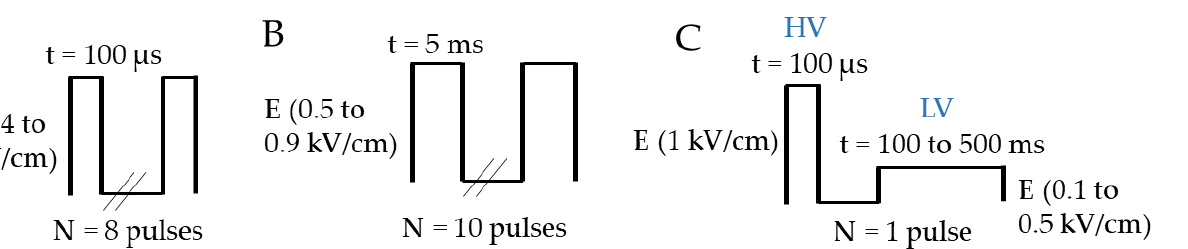
Figure 1. Schematic representation of electrical parameters used. ( A ) ECT pulse protocol (8 pulses of 100 µs at 1.4 to 2 kV/cm, 1 Hz), ( B ) GET pulse protocol (10 pulses of 5 ms at 0.5 to 0.6 kV/cm, 1 Hz) and ( C ) HV-LV pulse protocols with HV constant (100 µs at 1 kV/cm) and LV variant (500 to 100 ms at 0.1 to 0.5 kV/cm) .